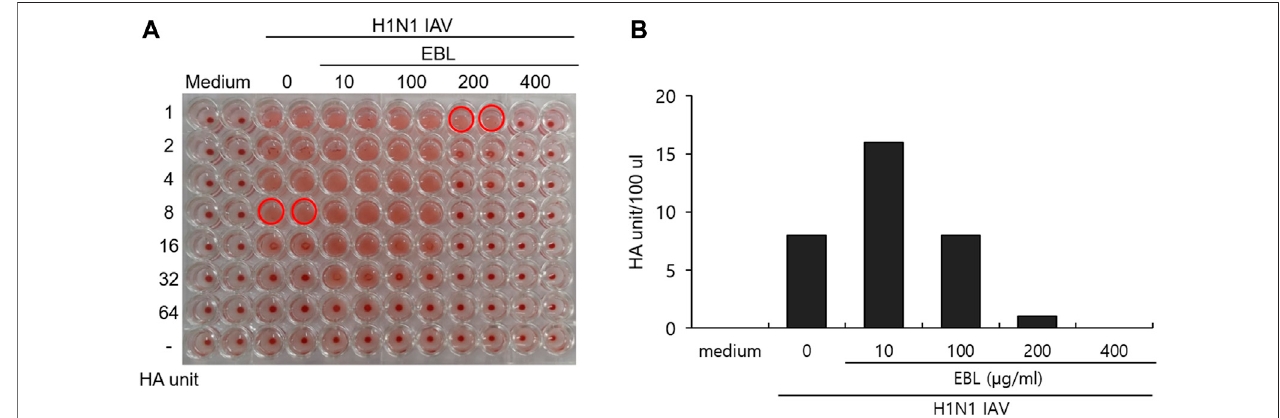
FIGURE 5 | Inhibitory effect of EBL on hemagglutination by IAV infection. (A,B) EBL at concentrations of 10, 100, 200, or 400 μ g/ml or medium was mixed with H1N1IAVfor1 hat4 ° C.ThemixturewasusedtocotreatontotheRAW264.7cells.At24 hpostincubation,thesupernatantsofcellswereseriallydilutedandmixedwith RBC cells to examine the effect of EBL on hemagglutination by IAV infection.